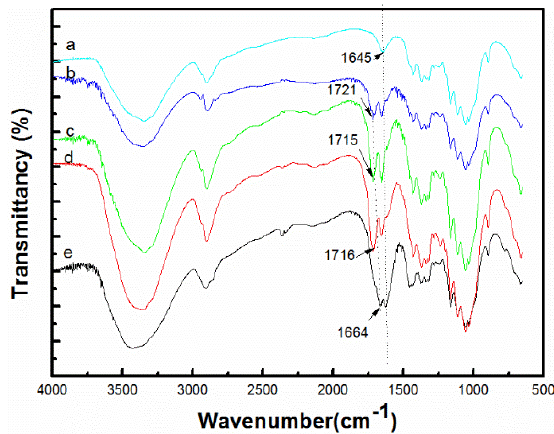
Figure 2. FTIR of ( a ) cellulose (bleached eucalyptus kraft pulp), ( b ) CC (DS = 0.143), ( c ) CC (DS = 0.133), ( d ) CC (DS = 0.123), and ( e ) CC (DS = 0.098).